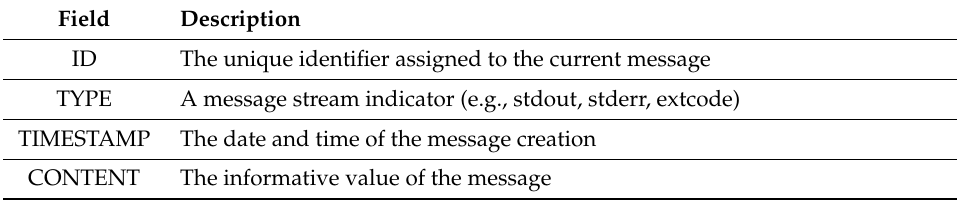
Table 2. Level 2 Socket.IO